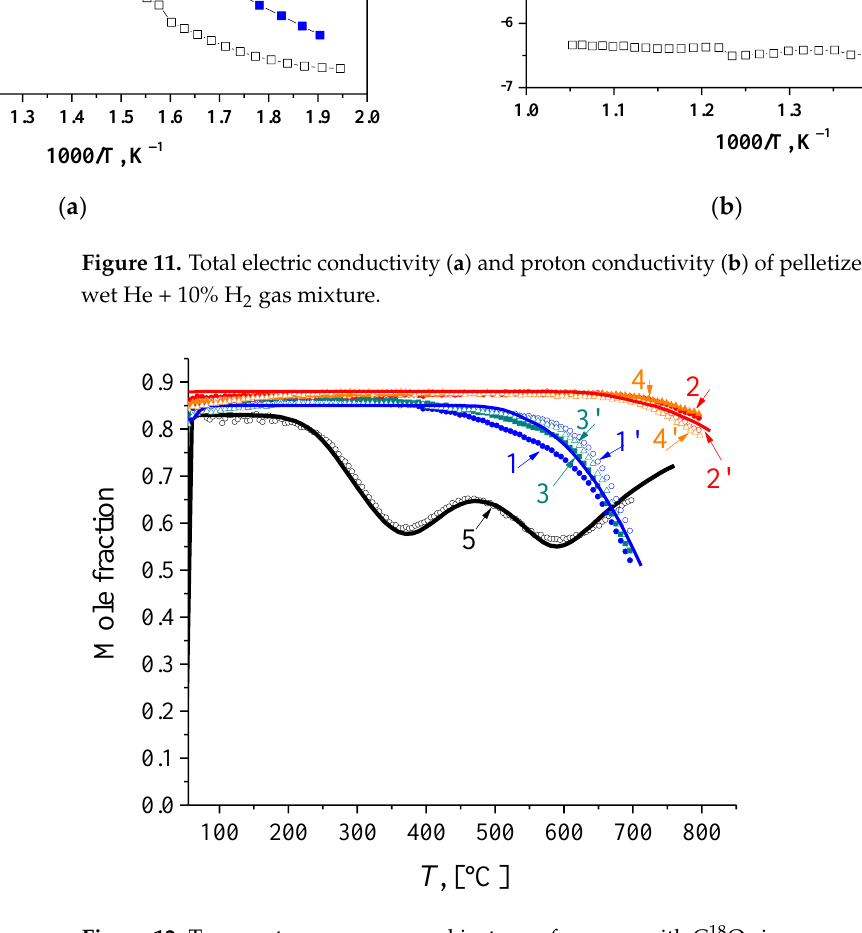
Figure 11. Total electric conductivity ( a ) and proton conductivity ( b ) of pelletized nanocomposites in wet He + 10% H 2 gas mixture.